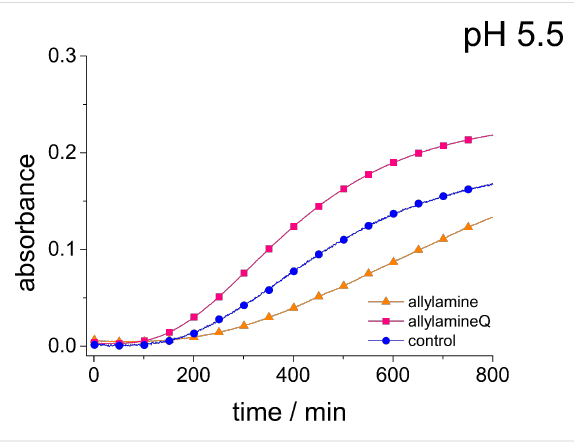
Figure 7: Absorbance of a 90 mM sodium metasilicate solution with 180 mM hydrogen phosphate in the presence of 10 mM allylamine and allylamineQ and of a pure sodium metasilicate solution with 180 mM hydrogen phosphate (control, blue circles) measured as a function of time up to 800